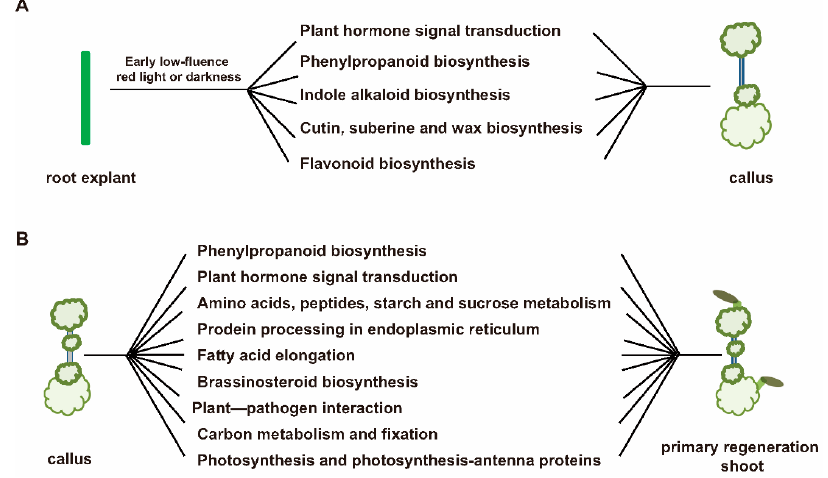
Figure 6. Functional enrichment of differential genes in the CIM and SIM stages under the early low-fluence red light or darkness. ( A ) Differential gene enrichment analysis revealed the biological pathway for the transition from root explant to callus in DCIM7 vs. RCIM7, DWCIM7 vs. DCIM7 and DWCIM7 vs. RCIM7. ( B ) Differential gene enrichment analysis revealed the biological pathway for the transition from callus to primary regeneration shoot in the SIM stages (DWSIM7 vs. DSIM7, DWSIM7 vs. RSIM7 and DSIM7 vs. RSIM7) and in the transitory stage from CIM to SIM (DCIM7 vs. DSIM7 and RCIM7 vs. RSIM7). RCIM7 (24 h R-W treatment, CIM 7 d); DCIM7 (24 h D-W treatment, CIM 7 d); DWCIM7 (D-W treatment, CIM 7 d); RSIM7 (24 h R-W treatment, SIM 7 d); DSIM7 (24 h D-W treatment, SIM 7 d) and DWSIM7 (D-W treatment, SIM 7 d); D-W (the control treatment); 24 h D-W, early 24 h dark and then shifting to 6 days white light in CIM followed by white light throughout SIM; 24 h R-W, early 24 h red light shifting to 6 days white light in CIM, followed by white light treatment in SIM; CIM, callus induction medium; SIM, shoot induction medium.